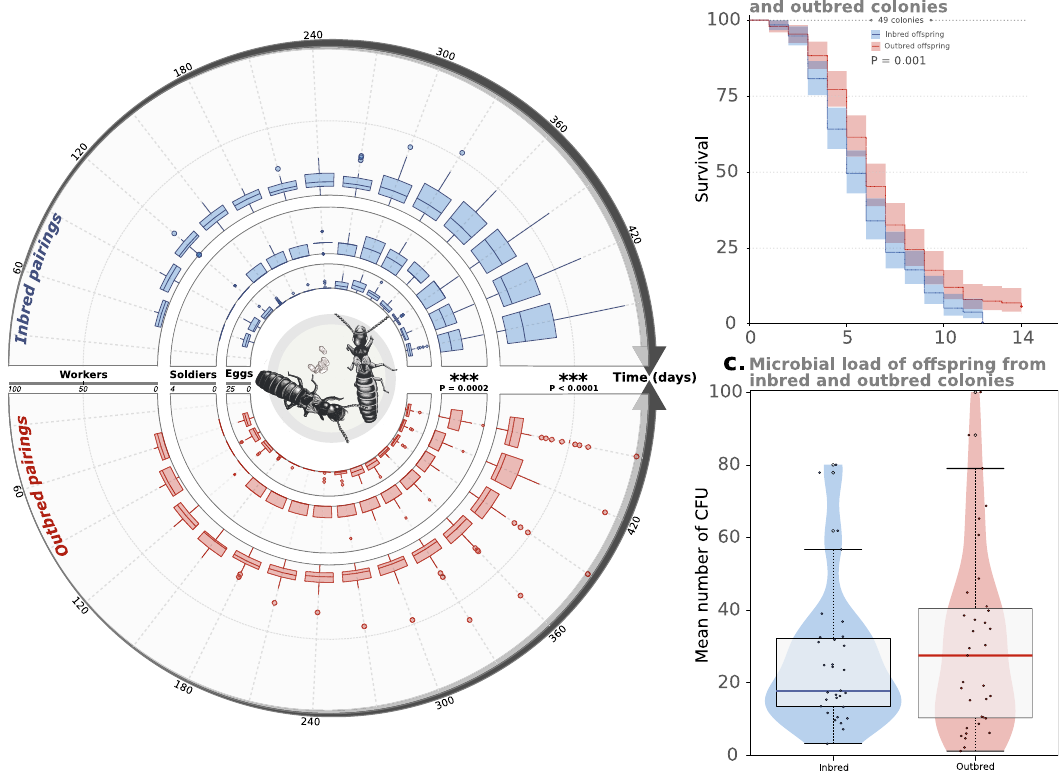
Fig. 5 Productivity of inbred and outbred pairing, as well as survival and microbial load of their offspring. a Graphical representation of the productivity of incipient colonies over the overall duration of the experiment (450 days, 15 months). Productivity is measured as the number of workers (outer circle), soldiers (middle circle), and eggs (inner circle) for each pairing. The productivity of inbred pairings is reported on the upper half-circle, while the productivity of outbred pairings is reported on the bottom half-circle. Box plots represent median and 1st and 3rd quartile; whiskers include 95% of all observations; individual dots indicate outlier values. P values indicate a signi fi cant effect of the type of pairing on the number of workers and soldiers in a colony over time, with increased production in inbred colonies (see also Supplementary Figure S6). b Kaplan – Meier survival distributions of offspring from inbred and outbred colonies when challenged toward entomopathogens. c Violin plot of microbial loads (mean number of CFU) of offspring from inbred and outbred colonies. Box plots represent median and 1st and 3rd quartile; whiskers include 95% of all observations; dots indicate individual